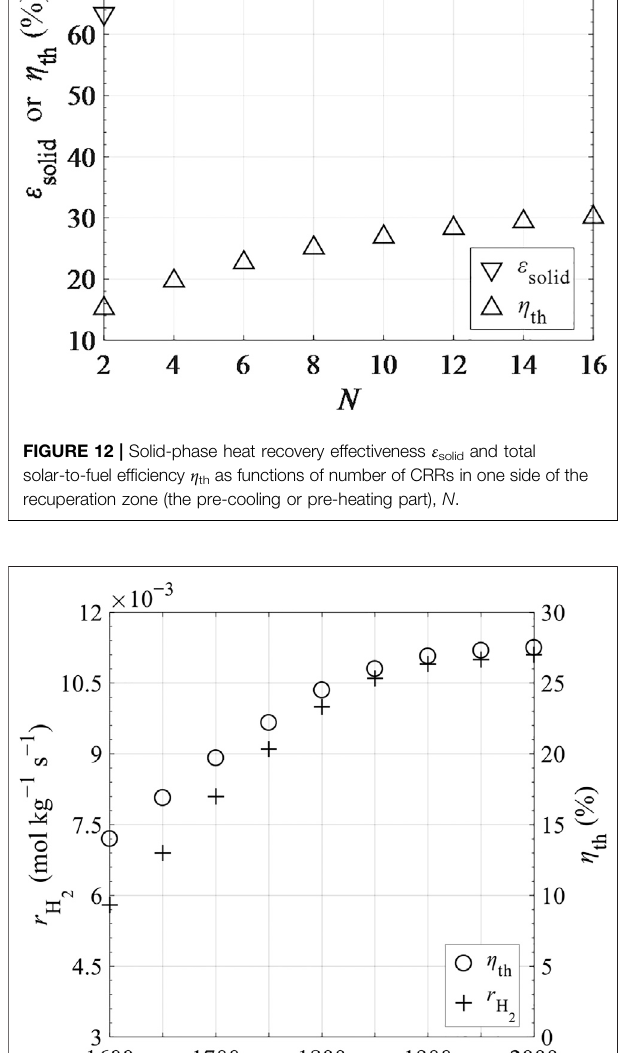
as a function of 2